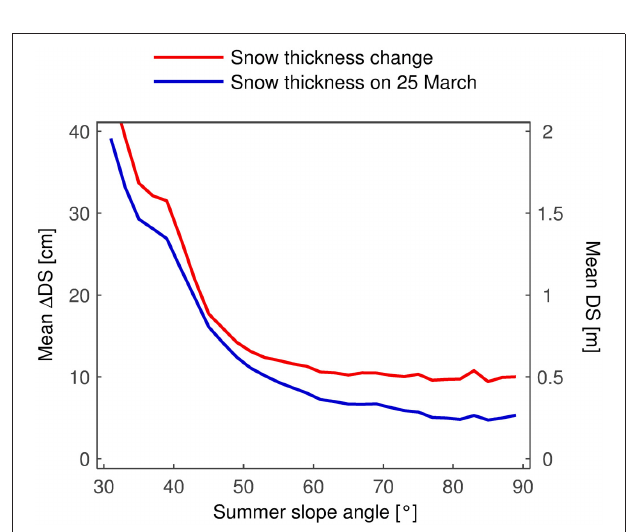
FIGURE 12 | Mean snow thickness and snow thickness change in slope angle classes of 2 ◦ . The complete rock face/study site is considered. After a rapid decrease, the curves flatten out and remain constant up to 90 ◦ . Note the plateau between 35 and 40 ◦ .